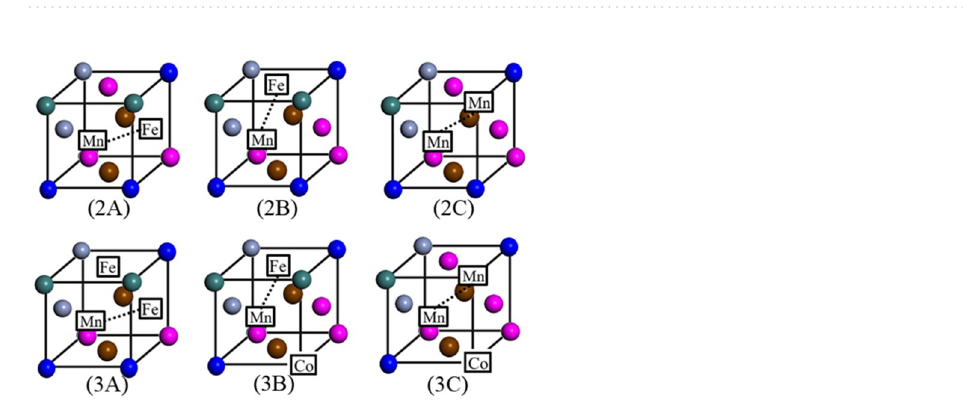
Figure 3. Atomic site of a perfect crystal with a uniform distribution of elements in the unit cell.